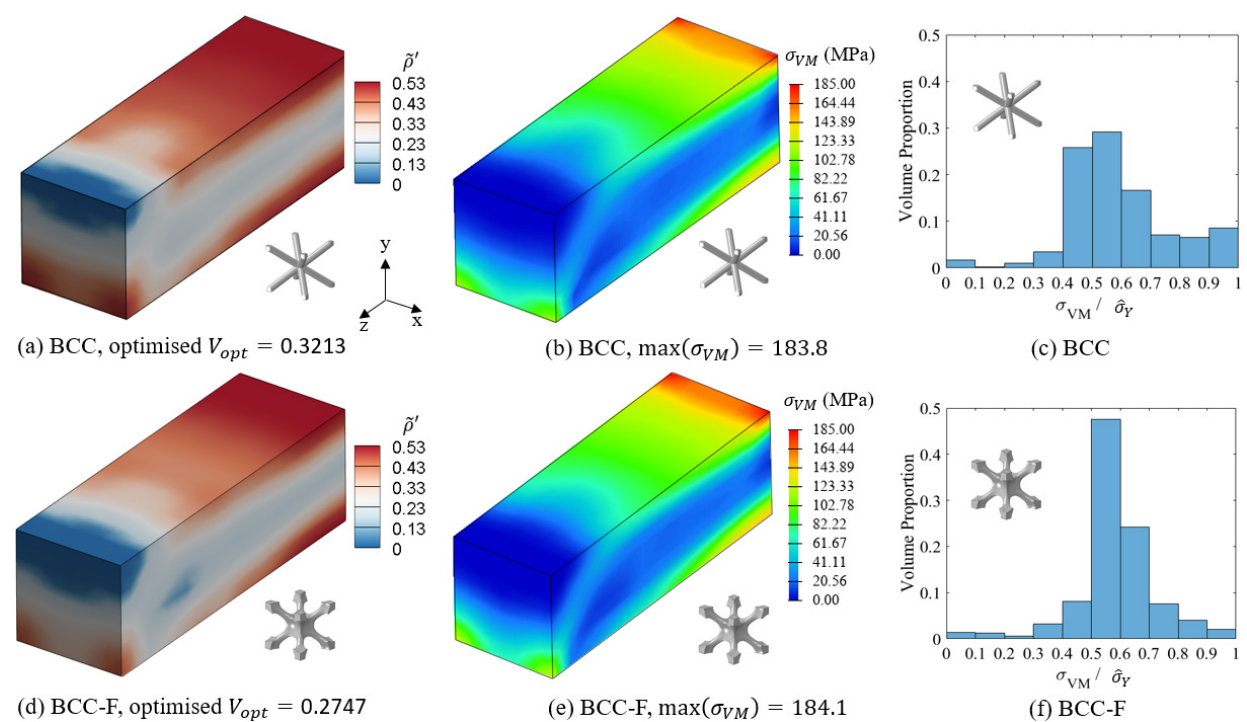
Figure 18. Comparisons of ( a , d ) the relative density ( (cid:101) ρ (cid:48) ) distributions and the optimised volume fractions ( V opt ), ( b , e ) the von Mises stress ( σ VM ) contours, and ( c , f ) the volume proportion histogram of 𝜎 (cid:3023)(cid:3014) /𝜎(cid:3548) (cid:3026) for the optimised MBB beam with the BCC (the top row) and the BCC-F (the bottom row) lattices.